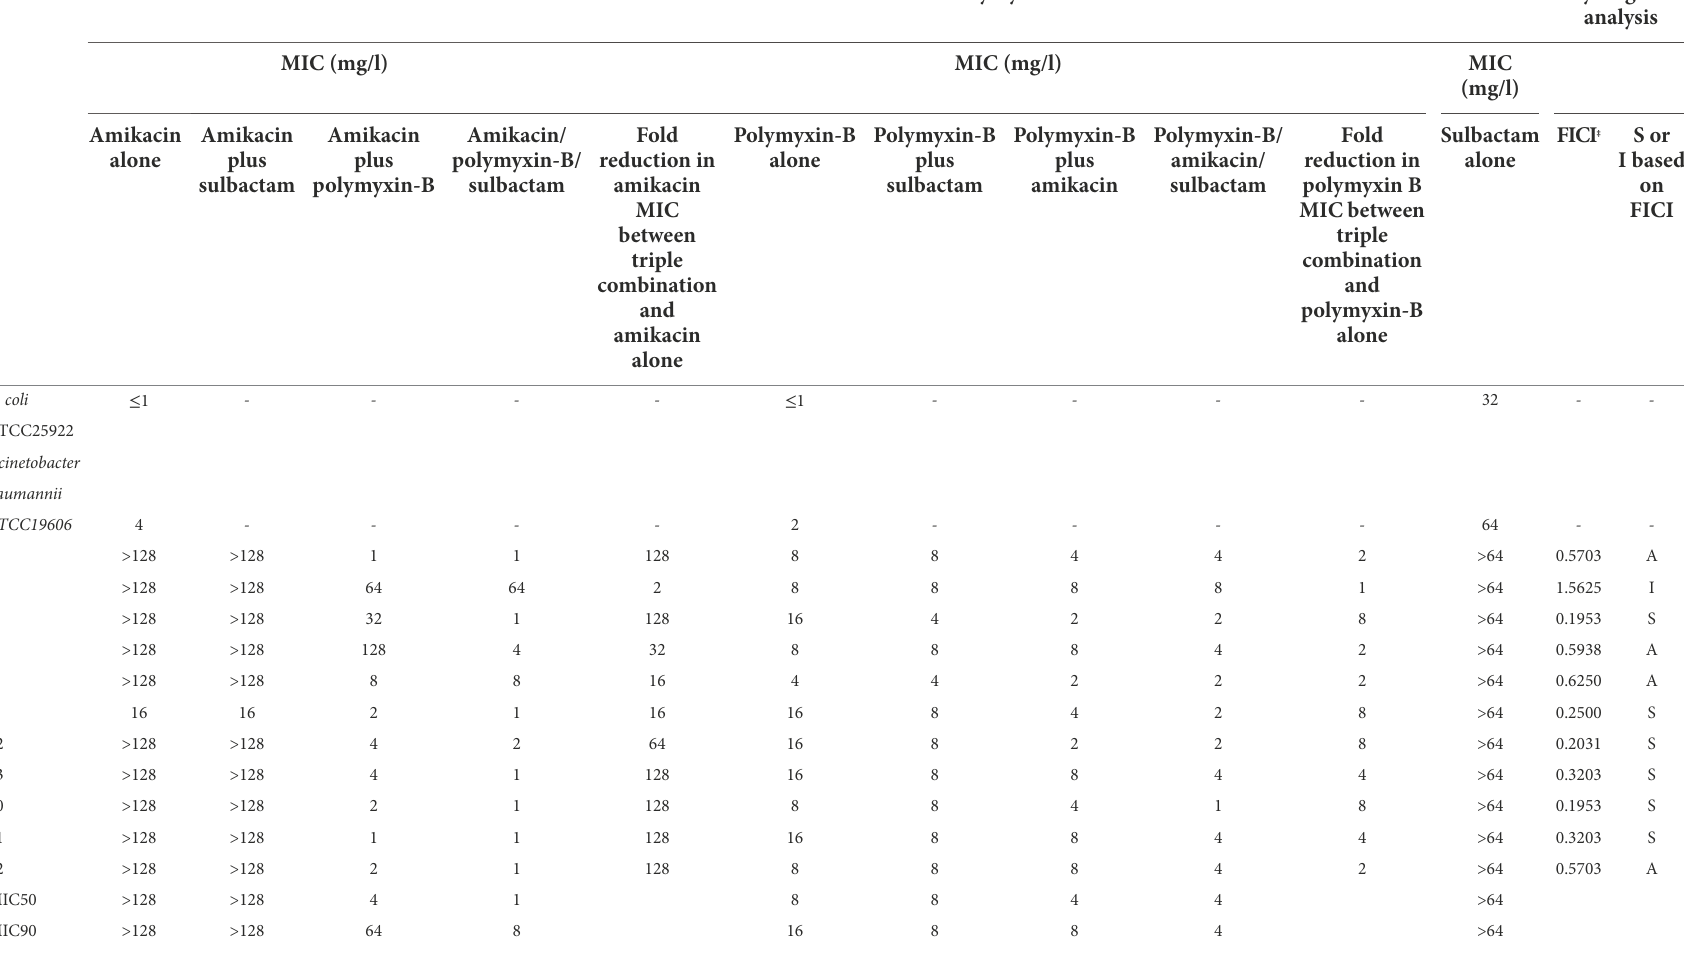
TABLE 2 Minimum inhibitory concentrations of amikacin and polymyxin B alone or in combination with or without sulbactam (fixed at 4 mg/l) against carbapenem-resistant Acinetobacter baumannii isolates and fractional inhibitory concentration index (wherein sulbactam was fixed at 4 mg/l).